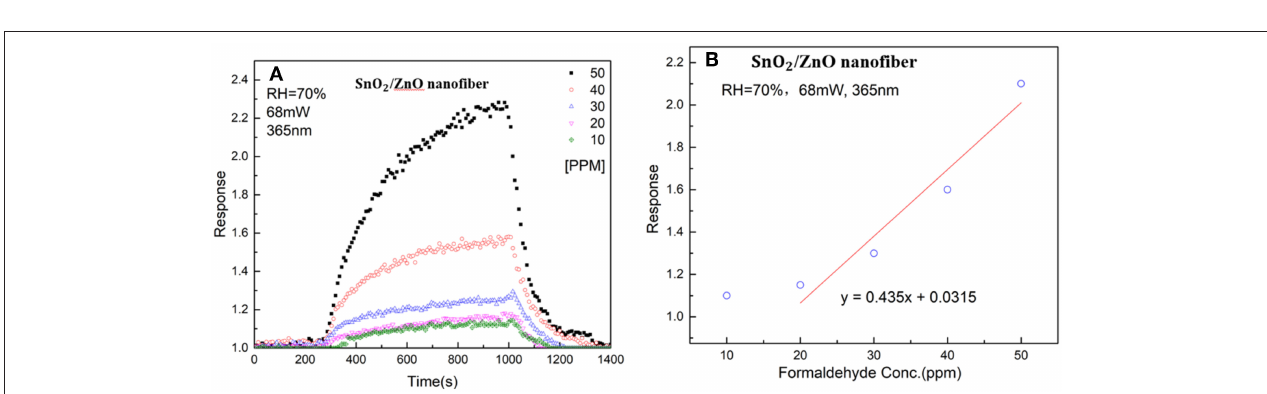
FIGURE 5 | The gas response of the SnO 2 /ZnO heterojunction based sensor to three different UV LED lights in ambient: (A) Wavelength effect and (B) Power density effect.